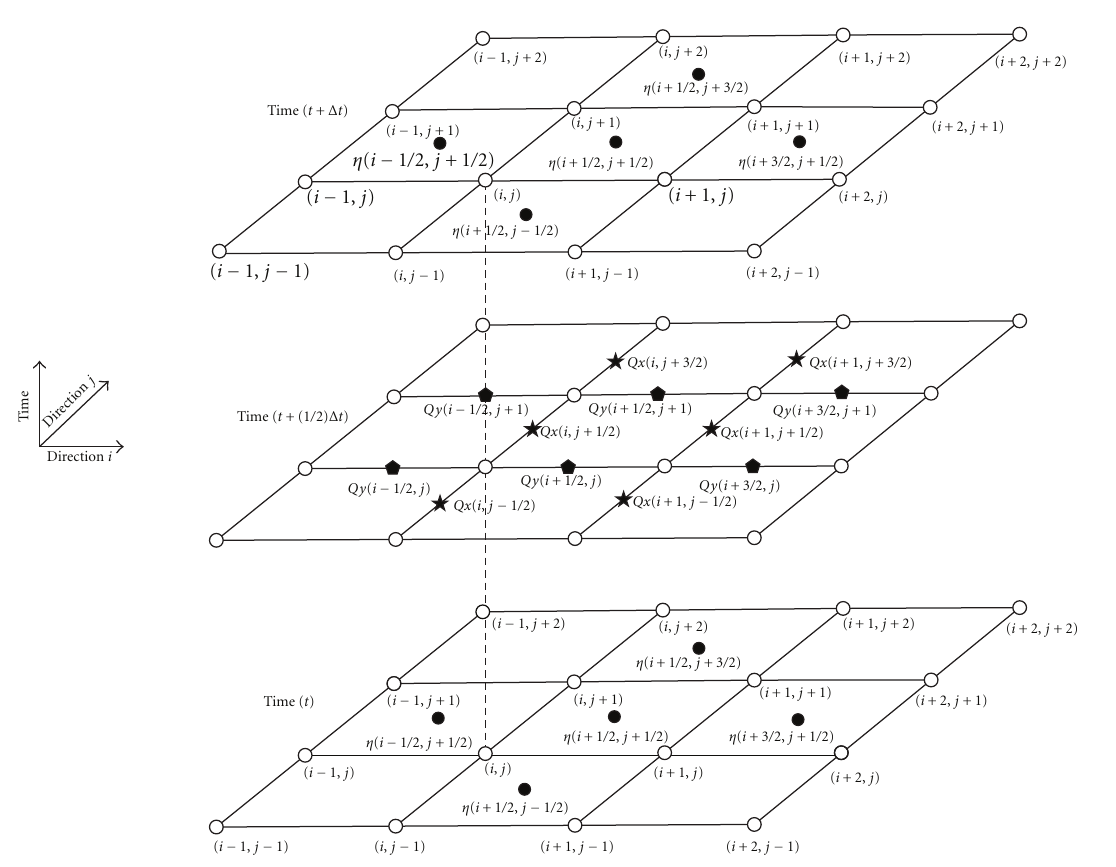
Figure 3: Computational module for the calculation of the wave